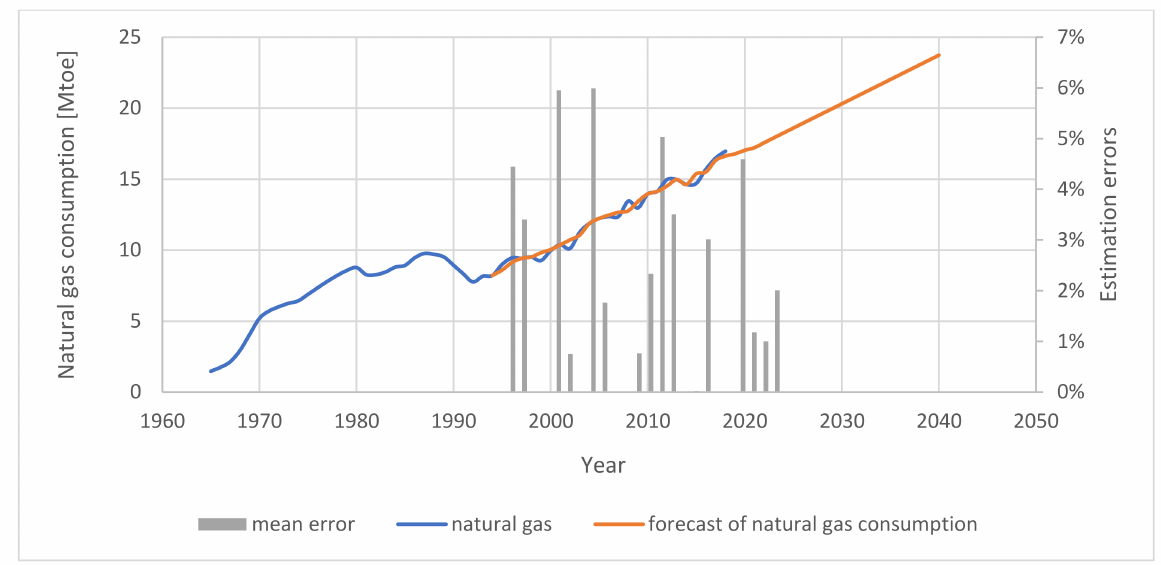
Figure 7. Theoretical model of natural gas consumption together with analysis of errors; own